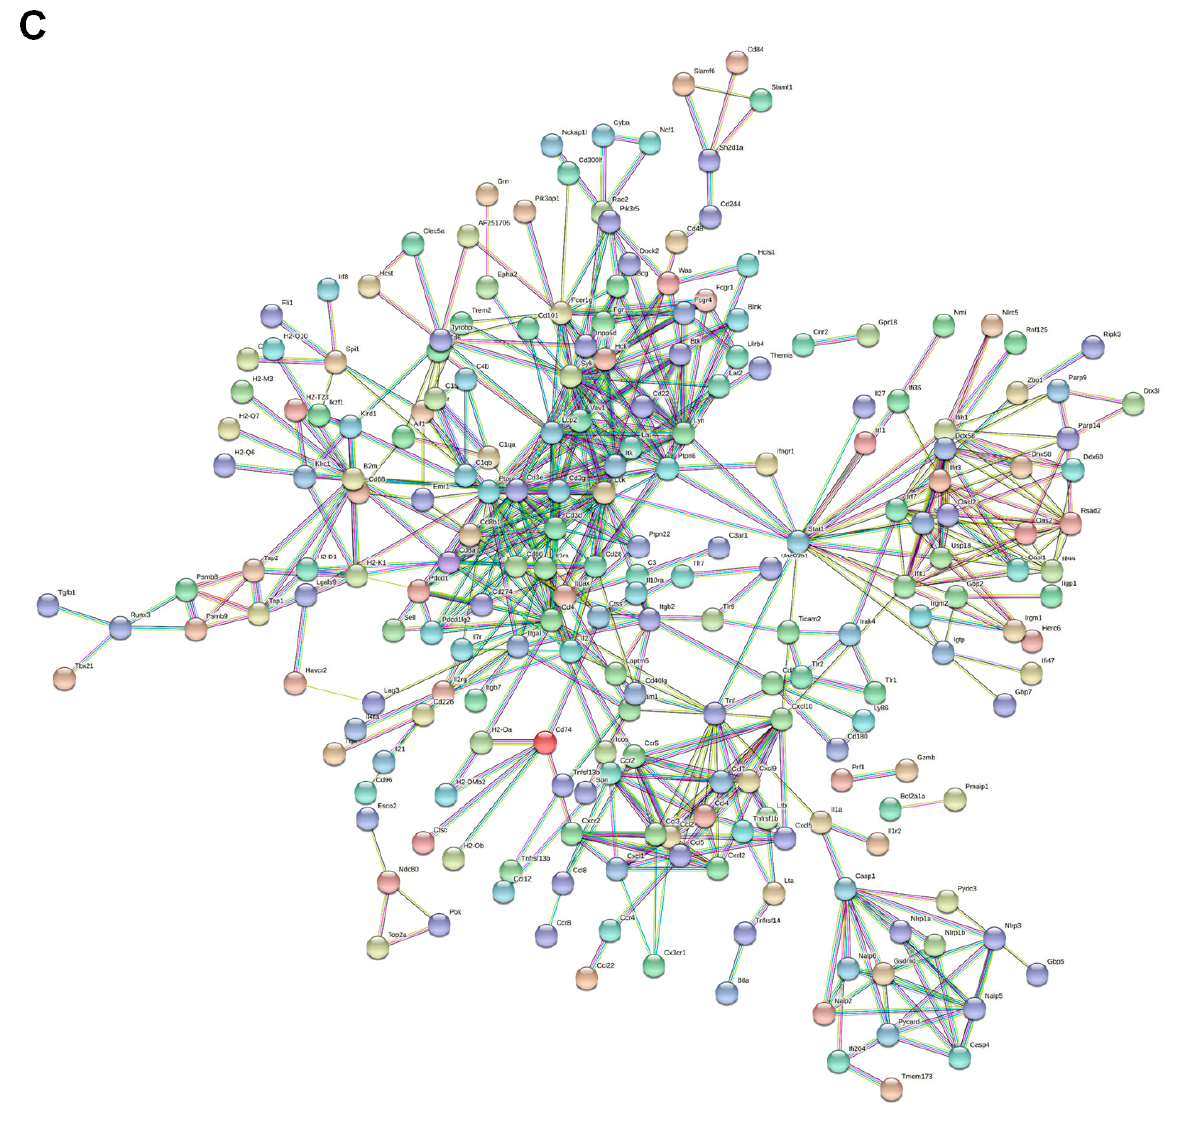
Figure 1. Gene ontology (GO) analysis of upregulated genes from the RNA-seq data. ( A ) Dot plot of enriched genes under GOBP (top ten) in EAE-affected hippocampi with >1.5-fold change and p- value < 0.05. ( B ) Interactive plot showing the relationship between enriched pathways. ( C ) STRING analysis of the top five pathway genes in GOBP at the highest confidence level (0.9).